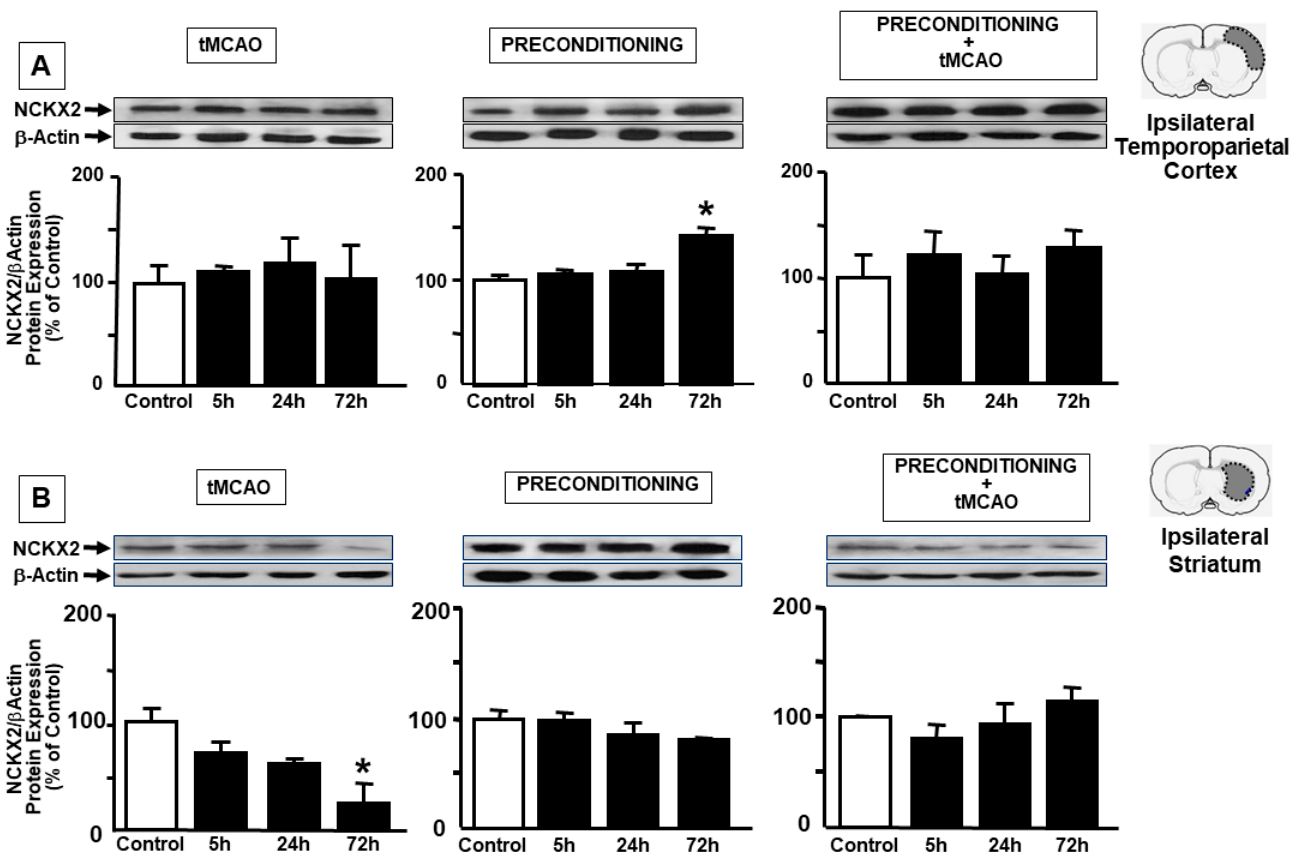
Figure 1. NCKX2 PROTEIN EXPRESSION IN RAT IPSILATERAL CORTEX AND STRIATUM AFTER tMCAO, PRECONDITIONING, AND PRECONDITIONING + tMCAO Time course of NCKX2 protein expression after tMCAO, preconditioning and preconditioning + tMCAO in the ipsilateral temporoparietal cortex (panel A ) and in the striatum (panel B ). A representative brain slice cartoon indicating the area of interest is on the top of the panels of the figure. Data were normalized on the basis of β -actin levels and expressed as a percentage of control animals. On the x-axis is the reperfusion time interval. Values are mean ± SEM. * p < 0.05, compared with control. n = 5 animals for each column.